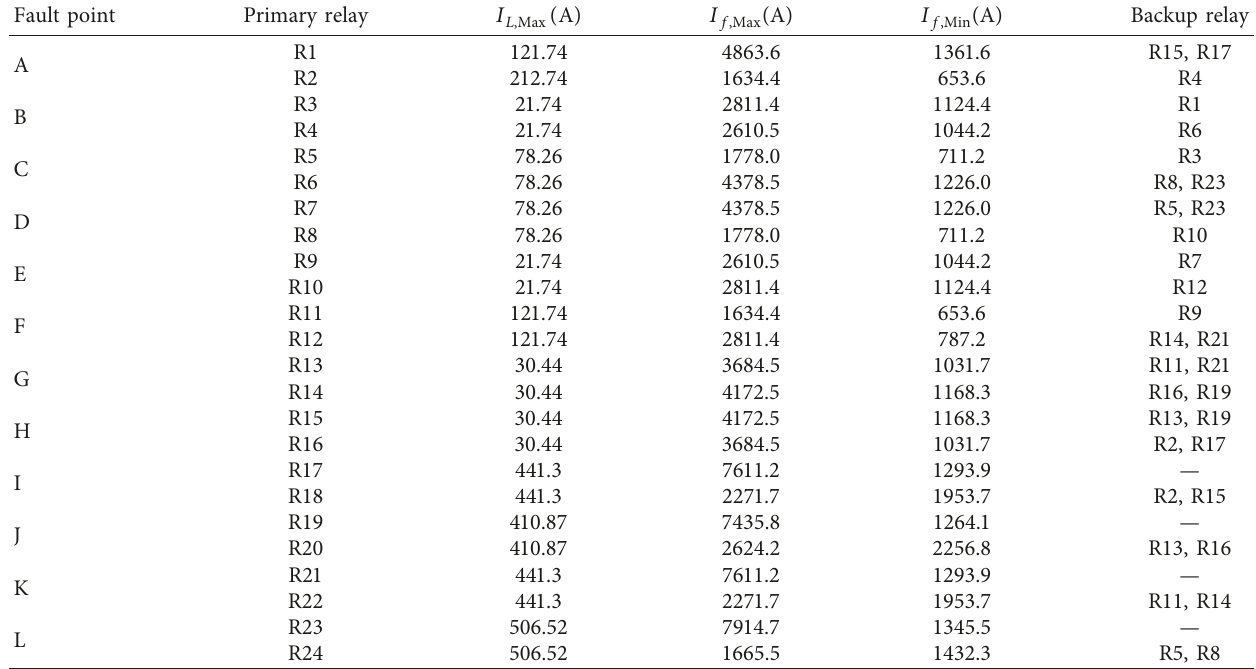
Table 14: Related parameters for the 9-bus system [4].